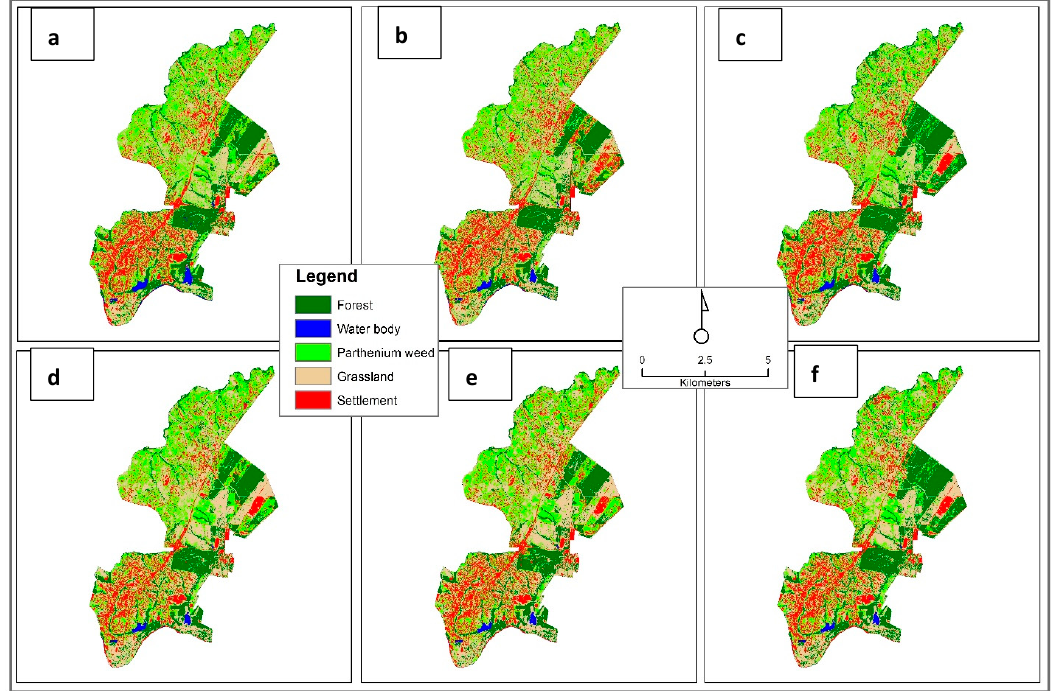
Figure 3. Spatial distribution of Parthenium weed and surrounding land-cover with optimal features from ReliefF on first ( a ), second ( b ) and third ( c ) training set and from full dataset on the first ( d ), second ( e ) and third ( f ) training set.